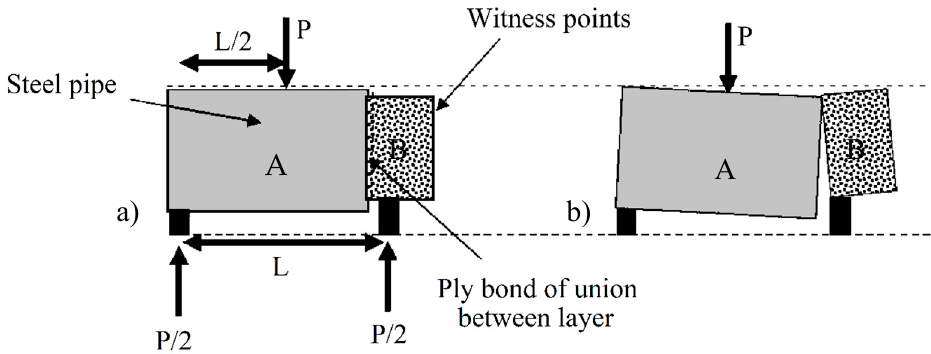
Figure 1. Force and stress diagram acting on the specimen in the LCB (Laboratorio de Caminos de Barcelona) shear test.